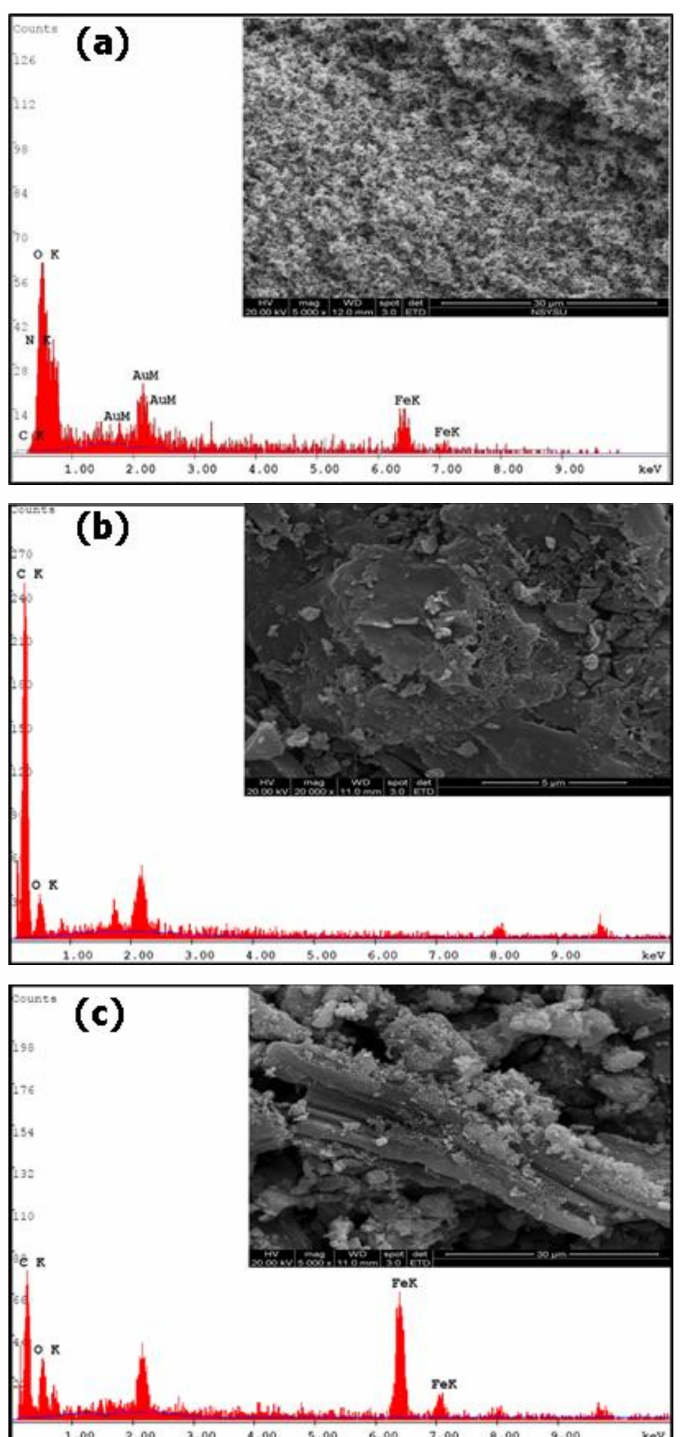
Figure 1. Environmental scanning electron microscopy–energy-dispersive X-ray spectrometry (ESEM–EDS) images of ( a ) Fe 3 O 4 , ( b ) wood biochar (WB), and ( c ) Fe 3 O 4